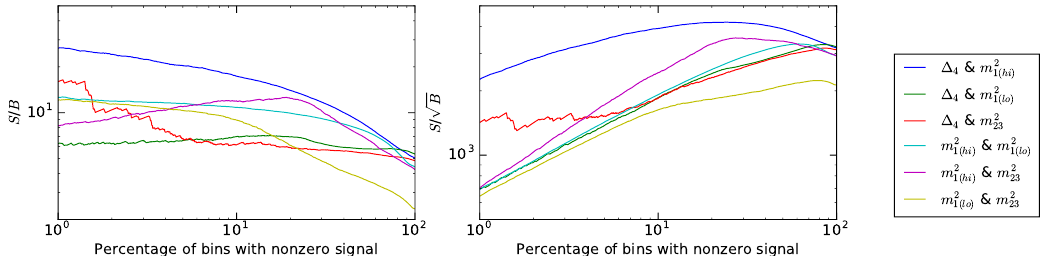
Figure 13 . Performance curves for pairs of variables among (cid:1) 4 and the m 2 variables, using the S = B and S = p B